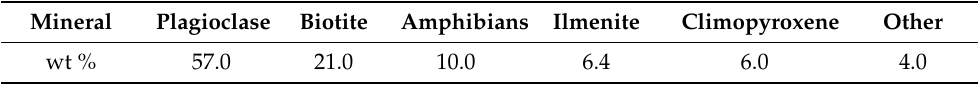
Table 2. Mineral composition of Kuru Black Diorite